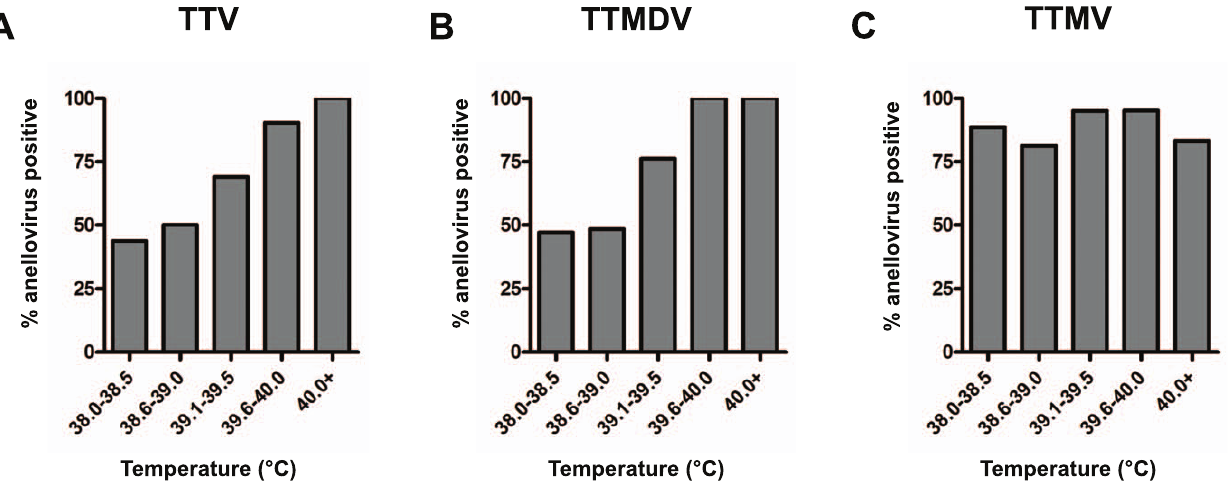
Figure 5. Detection of anellovirus DNA correlates with increasingly elevated temperatures in children. A–B . The percent of patients infected with detectable TTV ( A ) and TTMDV ( B ) rises as patient’s temperature increases. C . The percentage of patients with TTMV DNA detected is independent of temperature.